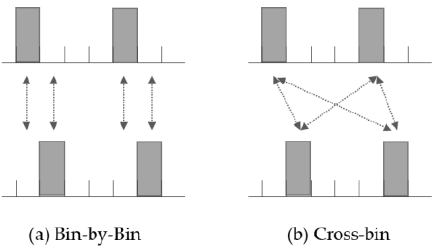
Figure 6. Comparison of two methods for measurement of histogram similarity.